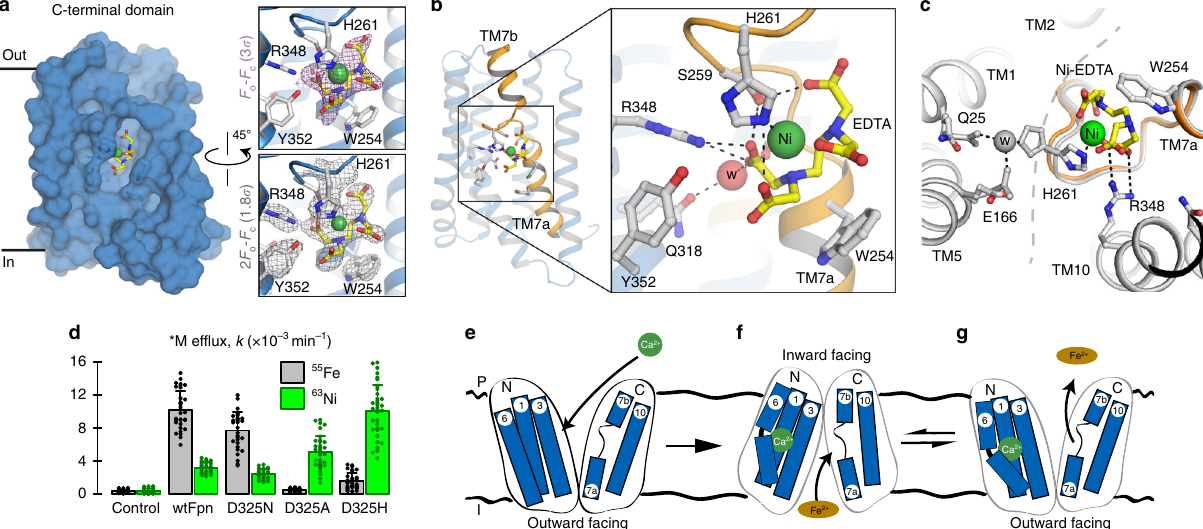
Fig. 7 Putative substrate-binding site located in the C-terminal domain. a Surface representation of the C-terminal domain of BbFpn, viewed from the central cavity. The pocket formed by the non-continuous TM7 is in the center of the domain, with the Ni-EDTA molecule shown in ball-and-stick. Insets show F o – F c omit (top) and 2 F o – F c map (bottom) of the Ni-EDTA site. b Close-up view of the Ni-EDTA-binding site and coordination. Main hydrogen bonds are indicated by dotted lines. R348 forms a salt-bridge to one of the carboxylate groups of the EDTA moiety, shown in yellow, whereas H261 is a direct ligand to the metal (green sphere). c Superposition of the Ni-EDTA bound structure and the previously determined open inward conformation (gray; PDB entry 5AYO) illustrating conformational change of H261. d Effects of mutating residues within the putative metal-binding site of human Fpn. 55 Fe ef fl ux (black) and 63 Ni ef fl ux (green) from control oocytes and oocytes expressing wtFpn or one of several amino-acid substitutions at residue D325 ( n = 24, 29, 32, 26, 30, 22, 28, 35, 33, 35, left to right). The bar graph indicates mean, SD, and individual scores. Two-way ANOVA revealed an interaction ( P < 0.001). Within 55 Fe ef fl ux, each mutant differed from wtFpn ( P < 0.001); and D325N ( P < 0.001) but neither D325A ( P = 0.78) nor D325H ( P = 0.025) differed from control. Within 63 Ni, all groups differed from control ( P < 0.001); D325A and D325H differed from wtFpn ( P < 0.001) but D325N did not differ from wtFpn ( P = 0.14). e – g Working model to illustrate Ca 2 + -activated Fpn-mediated iron ef fl